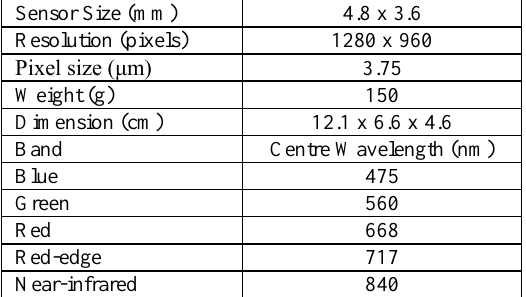
Table 1: Micasense RedEdge multispectral camera